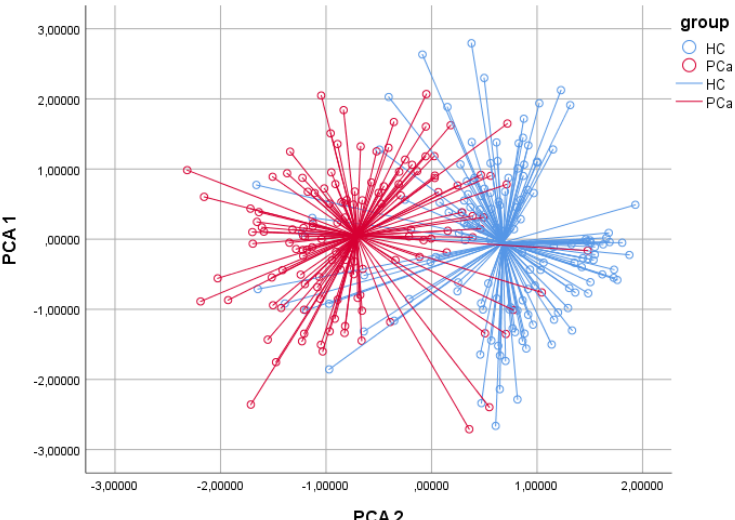
Figure 1. Two-dimensional principal component analysis plot. The two-dimensional PCA plot showed that patients with prostate cancer could be distinguished from healthy controls. Results obtained with CDA demonstrated correct classification in 85.3% of cases ( p < 0.001). In ROC analysis, discrimination accuracy between PCa patients and healthy controls was 0.90. Repeated analysis using the second measure of each collected urine sample provided comparable findings. Sensitivity and specificity were 83.1% and 87.6%, respectively.